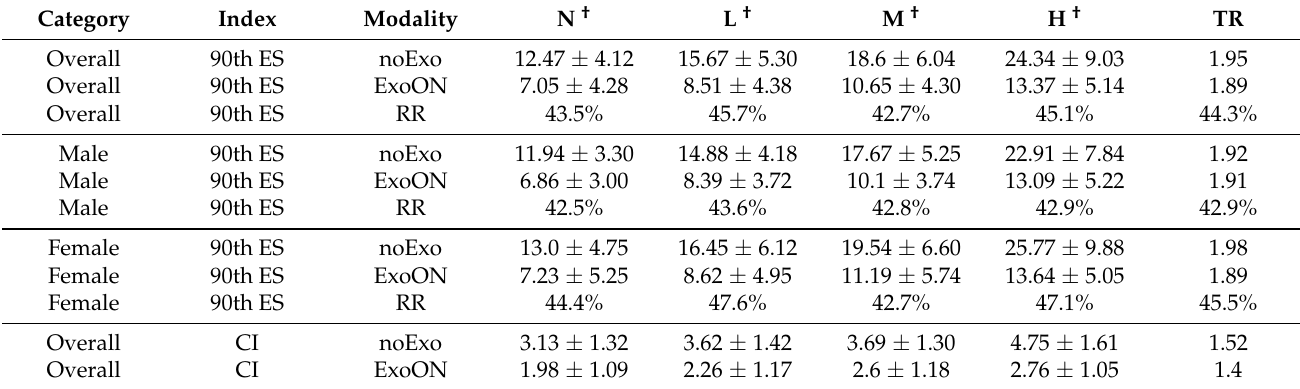
Table 4. Summary of the results and descriptive statistics (mean ± STD) due to the exoskeleton effect for the 30 ◦ trunk inclination. (†) the unit is [%MVC], RR stands for Reduction Rate, and TR stands for Trend.